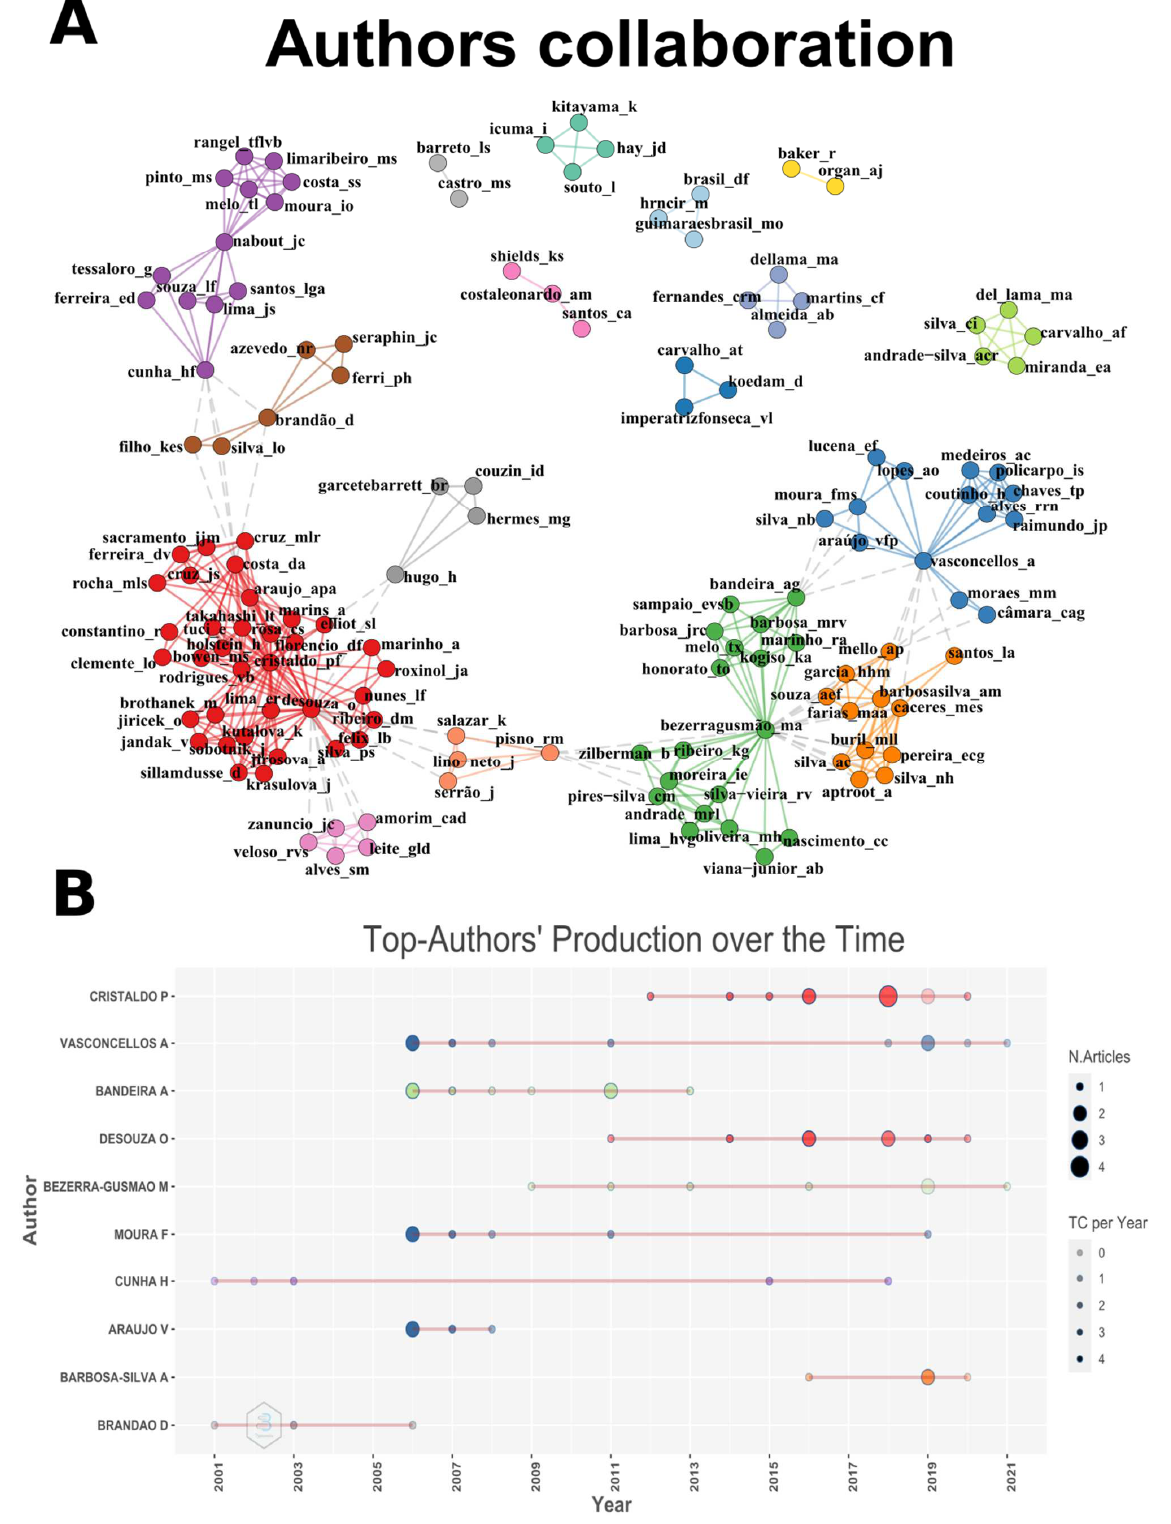
Figure 3. ( A ) Authors collaboration network. Different colors represent clusters formed according to links between authors. ( B ) Papers production of top authors over time (Years). Colors are linked to the colors of webs’ clusters. N. articles is the number of articles published.